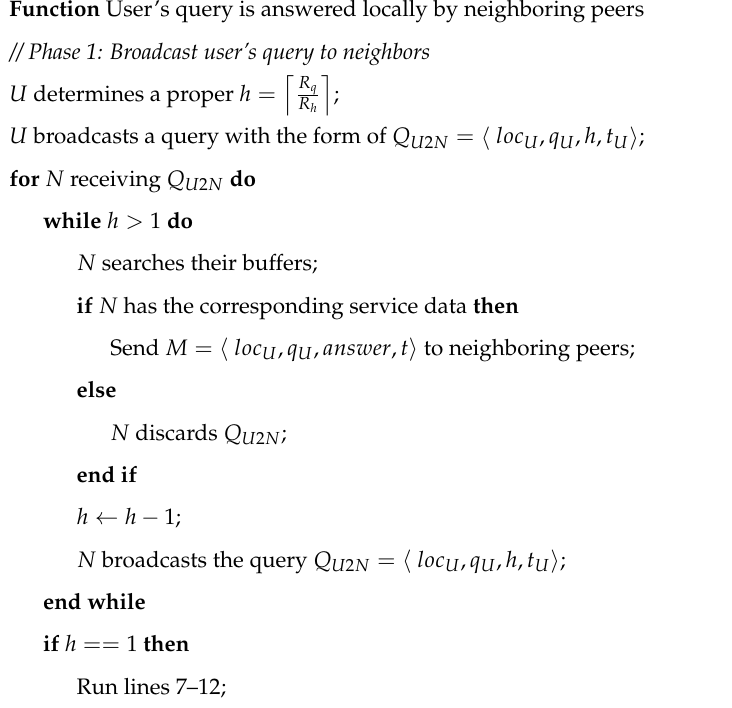
Algorithm 1 : Query to Neighbors